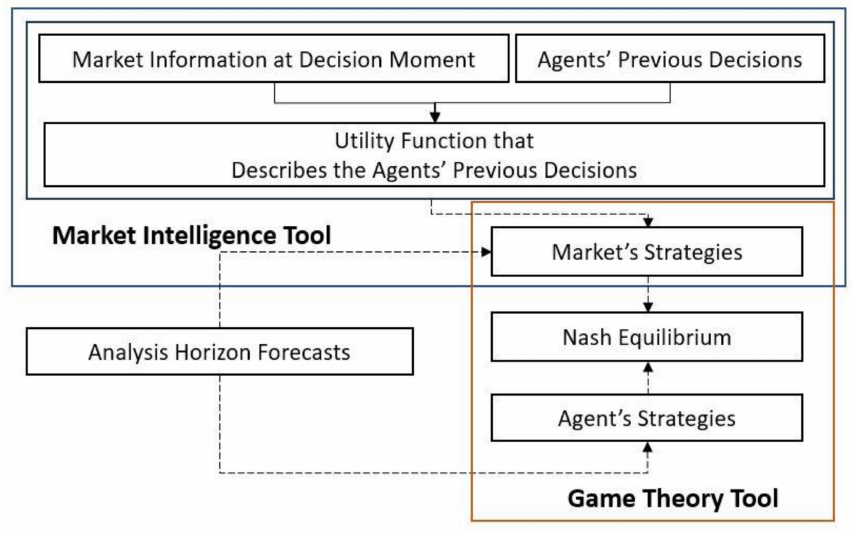
Figure 1. The proposed